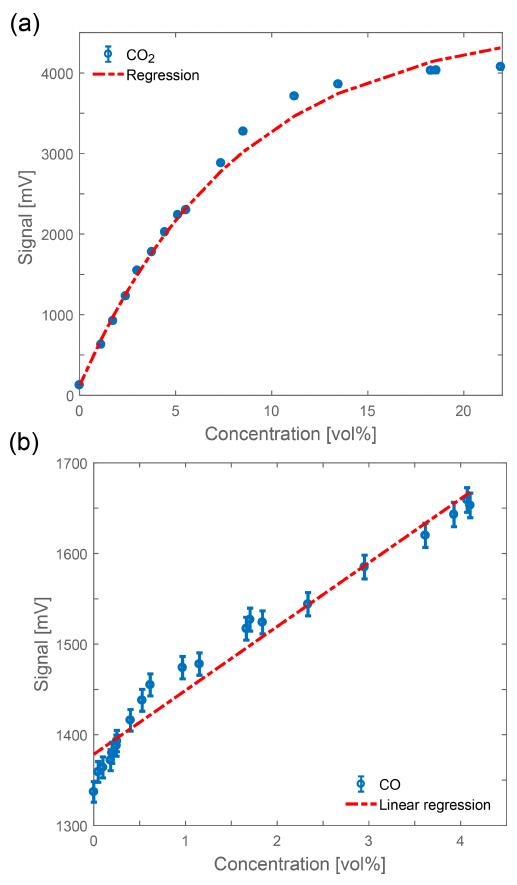
Figure 4. Measurements of (a) CO 2 and (b) CO at atmospheric conditions (1bar, 300K) and a 5cm absorption path. The slope is positive due to an inverted detector circuit. Included are the regres- sion functions as dotted